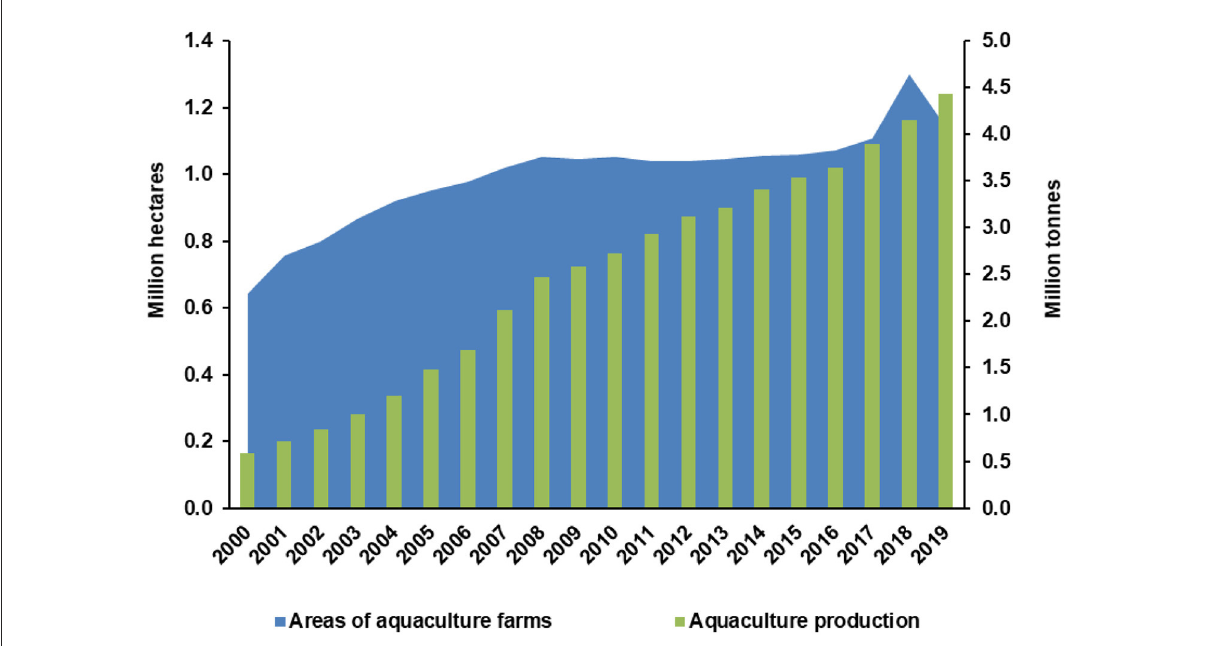
FIGURE3 Areas of aquaculture farms and aquaculture production in Vietnam, 2000–2019. Data source: Directorate of Fisheries (2017, 2018, 2019), and General Statistics Office (2018).